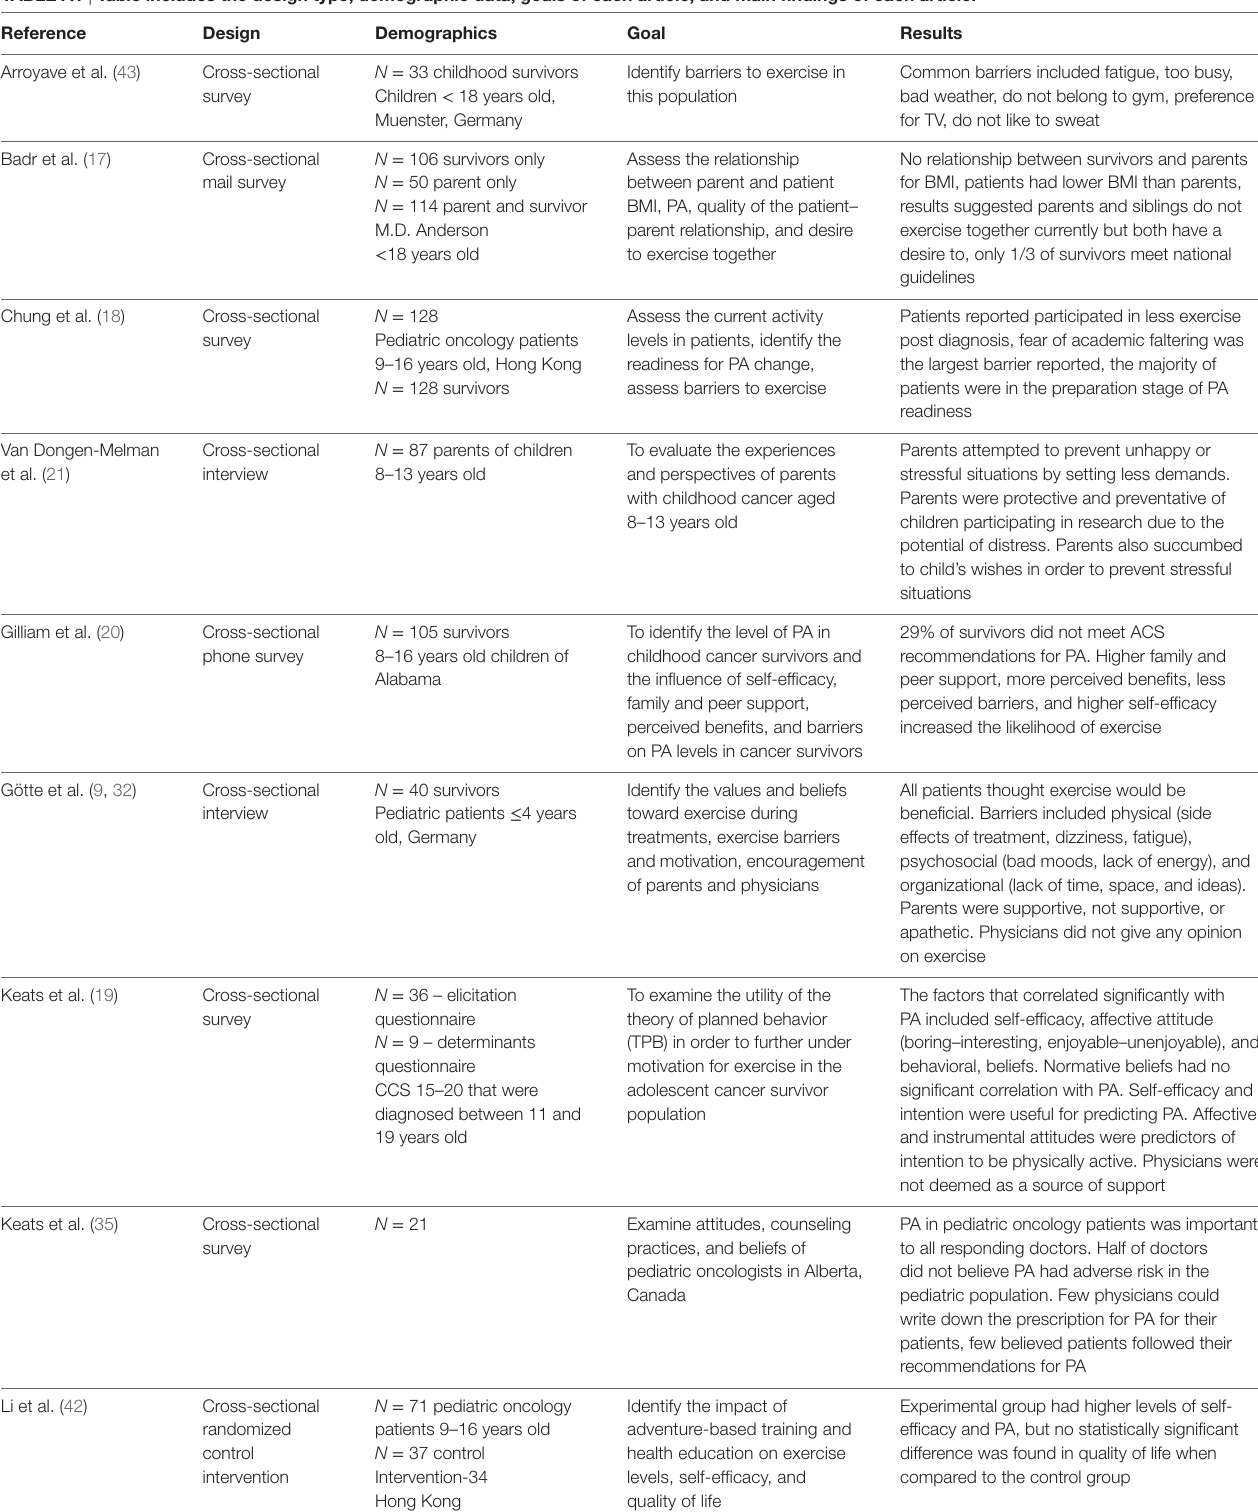
TABLe A1 | Table includes the design type, demographic data, goals of each article, and main findings of each